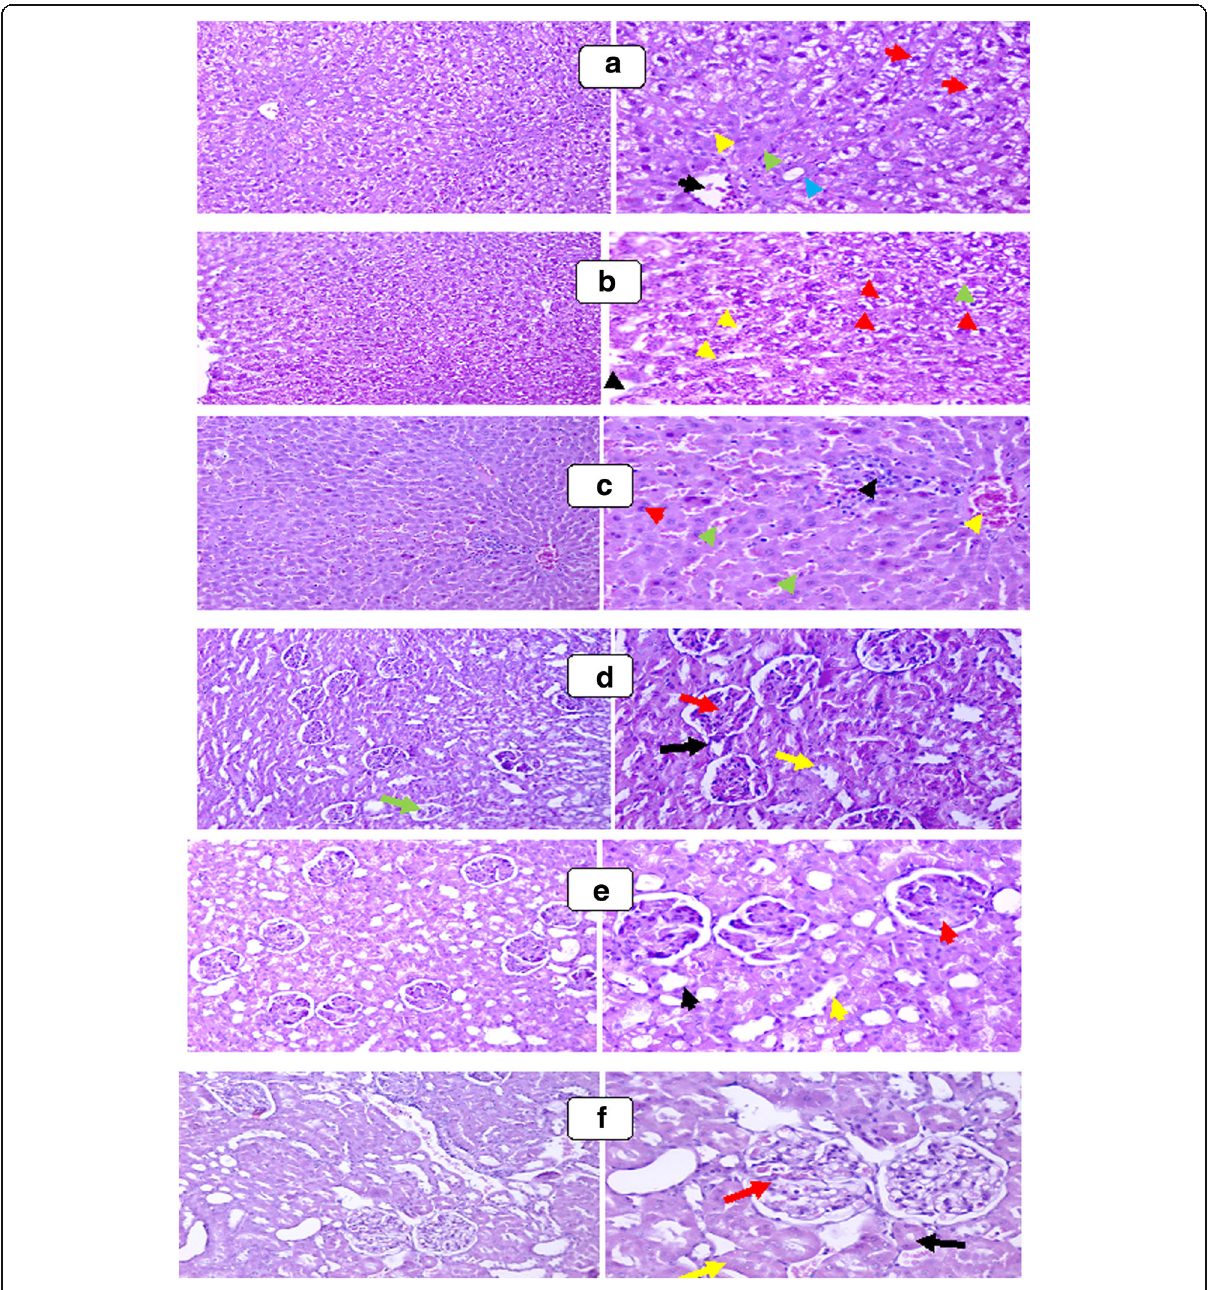
Fig. 5 a – c Liver section of ketoprofen rats left free without treatment for different durations (1 – 3 weeks) showed preserved hepatic lobular architecture, moderate diffuse hydropic degeneration and vacuolation (non-fatty type)(red arrows), congested sinusoids (yellow arrow), congested central vein (black arrow), scattered multinucleated hepatocytes (blue arrow), and mild infiltration of inflammatory (green arrow). d – f Kidney section from auto-recovery groups for 1 – 3 weeks showed few of glomeruli corpuscles (hyperplasia of epithelial cells lining the partial layer of Bowman ’ s capsule) (red arrow) with atrophy (green arrow), proximal and distal convoluted tubules with mild destructed epithelial lining cells (black and yellow arrow) (H&E, × 200,×